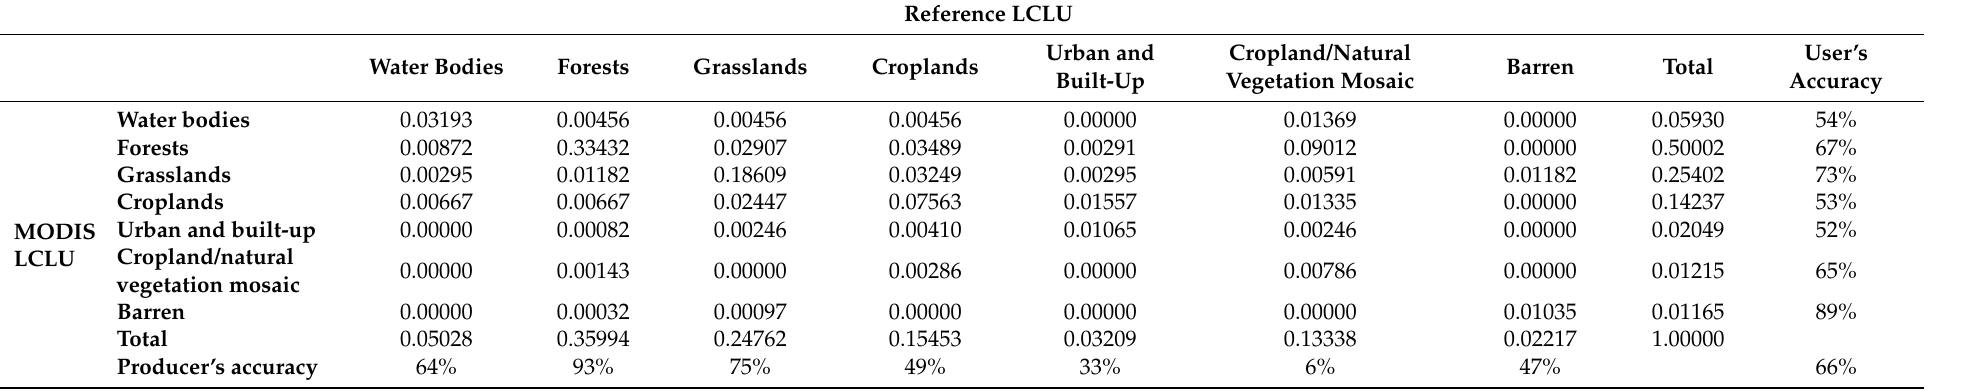
Table A1. Validation for MODIS LCLU in 2015 using very high-resolution